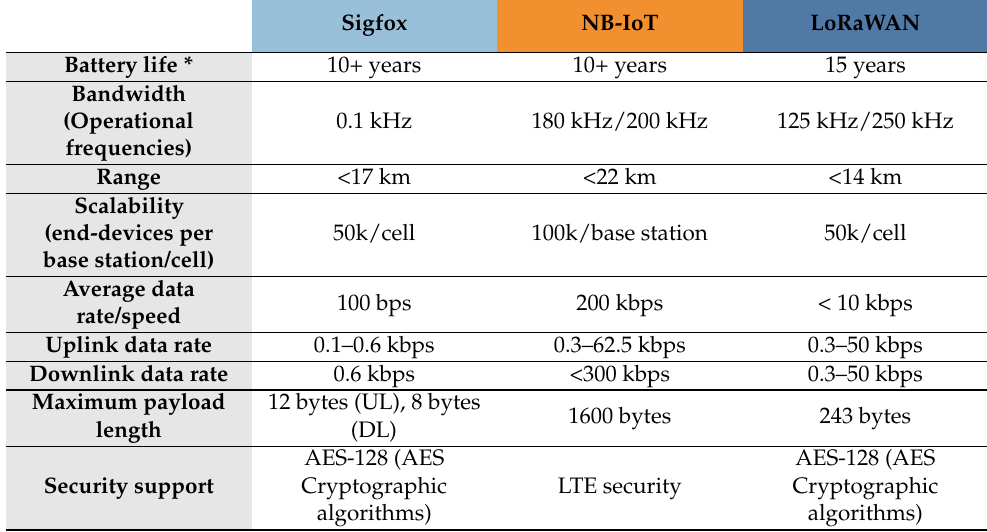
Table 1. A comparative view of the features of Sigfox, NB-IoT, and LoRaWAN. Sigfox NB-IoT